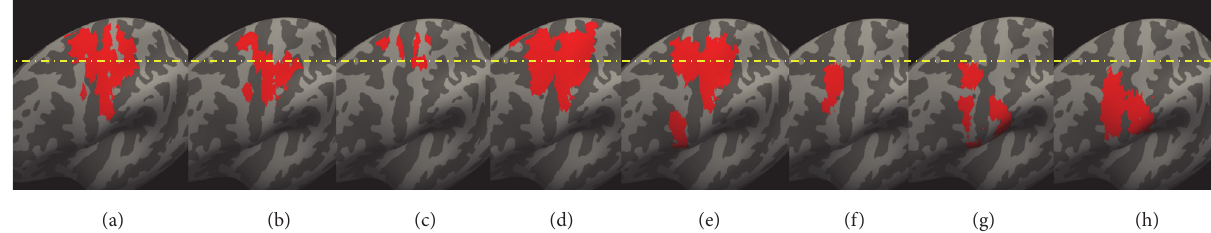
Figure 3: Contralateral hemisphere to the side of the affected nerve injury. (a) ReHo resting-state fMRI result. (b) ICC resting-state fMRI result. (c) fALFF resting-state fMRI result. (d) Increased activation evoked by ipsilateral hand movement in BP patients. (e) Increased activation evoked by ipsilateral hand movement in healthy controls. (f) Increased activation evoked by ipsilateral facial sensory stimulation in BP patients. (g) Increased activation evoked by ipsilateral facial sensory stimulation in healthy controls. (h) Increased activation evoked by mouth movement in healthy controls.